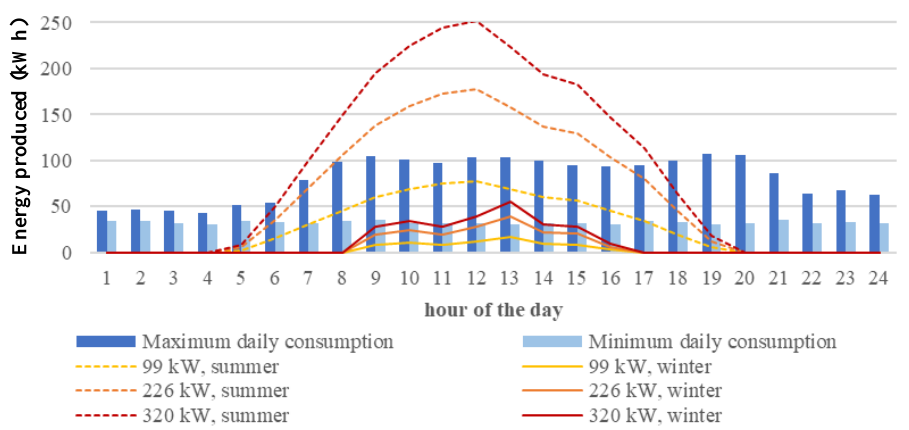
Figure 6. Hourly energy demand and hourly energy production with PV plants of three different